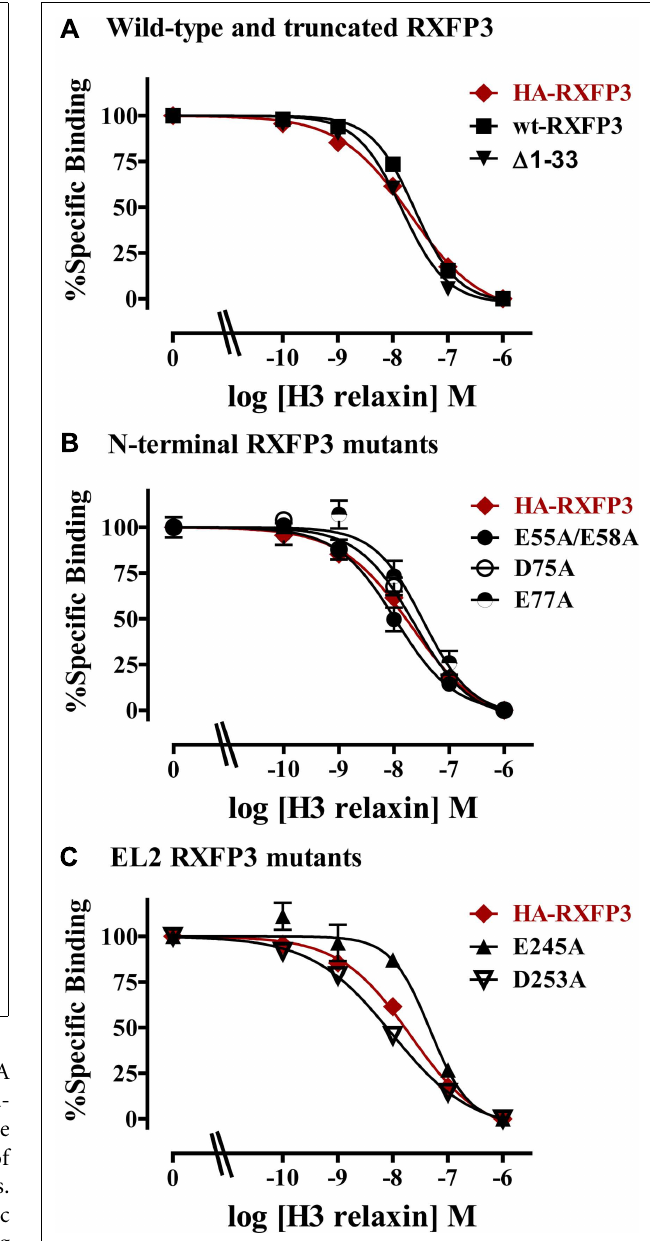
FIGURE 4 | Competition binding data for representative mutant RXFP3 receptors compared to HA-RXFP3. (A) Wild-type RXFP3 and the N-terminally truncated mutant Δ 1–33. (B) N-terminal domain mutants. (C) Exoloop 2 mutants. Data are presented as pooled % specific binding